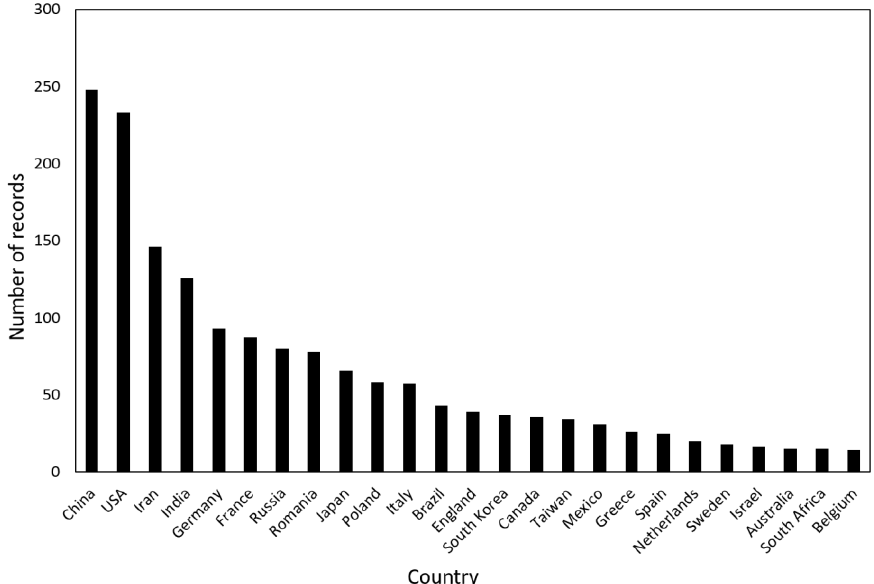
Figure 7. Top 25 publishing countries on the subject of fractal theory in thin film techniques and materials .